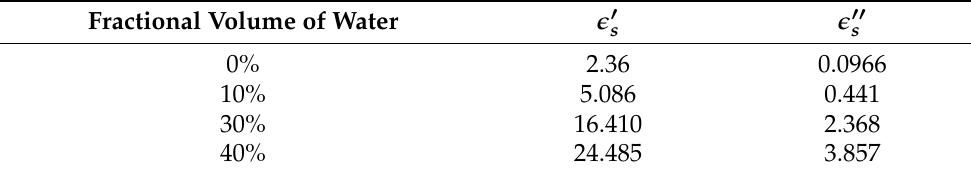
Table 1. Real and imaginary parts of relative permittivity of soil for different moisture